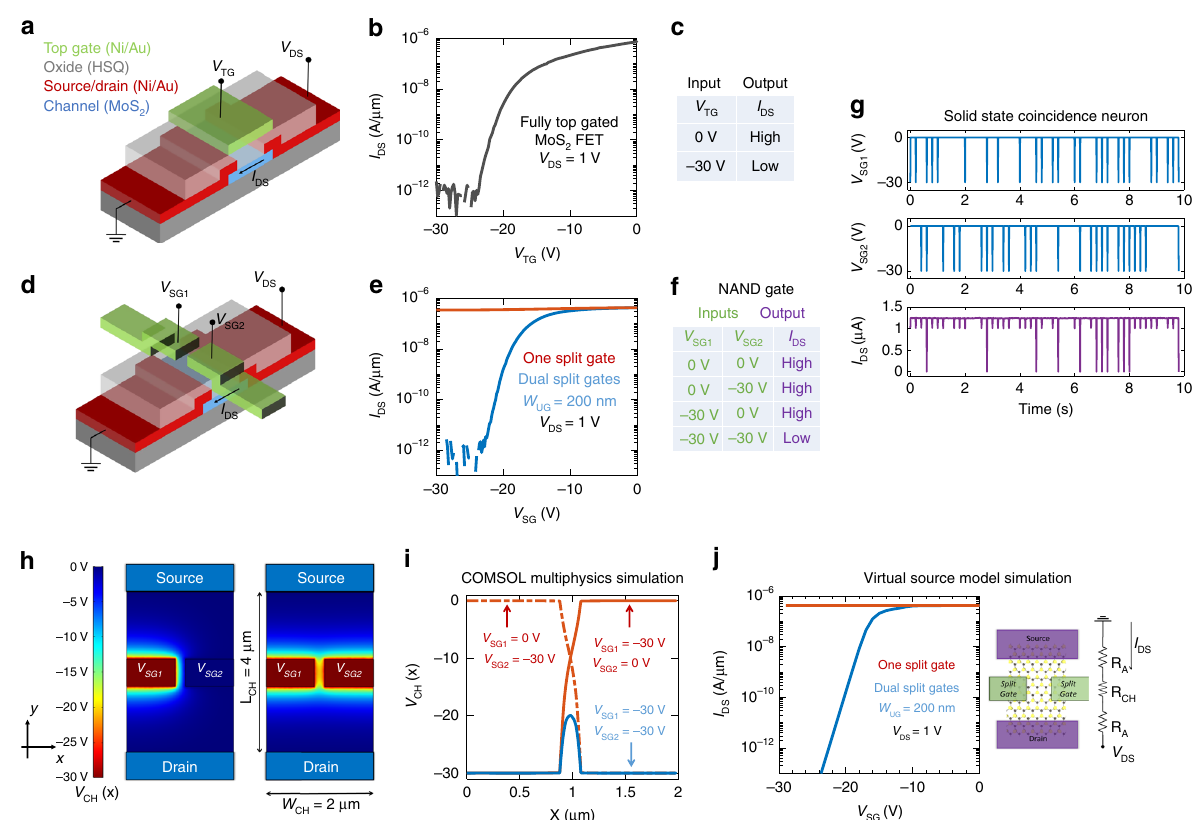
Fig. 2 Arti fi cial coincidence detector neuron. a Schematic and ( b ) Transfer characteristics of a fully top-gated MoS 2 fi eld effect transistor (FET) with 120 nm of hydrogen silsesquioxane (HSQ) as the top-gate dielectric and Ni/Au as the top-gate electrode. MoS 2 channel is few nm thick and is connected to Ni/Au metal contacts that serve as the source/drain terminals. The device is normally ON at V TG = 0 V and can be switched OFF by applying V TG = − 30 V with a high current ON/OFF ratio of ~10 6 . c Truth table showing that the device can be regarded as a one-input-one-output digital element. d Schematic of an MoS 2 FET with two split-gates separated by an ungated region of width W UG = 200 nm. e Transfer characteristics of the split-gated device when one of the split-gates is swept from 0 V to − 30 V while the other split-gate is held at a constant bias of 0 V (red curve) and when both split- gates are simultaneously swept from 0 V to − 30 V (blue curve). f Truth table showing that the split-gated device can be treated as two-input-one-output digital element with NAND logic. g Random sequence of voltage pulses of magnitude − 30 V are applied to the two spilt gates, V SG1 and V SG2 . The output current is completely suppressed or inhibited only when the spikes coincide suggesting that the split-gated MoS 2 FET can be used to mimic neural coincidence. h COMSOL multiphysics simulation of the 2D potential pro fi le when − 30 V bias is applied to either one or both split-gates. i 1D potential pro fi le along the channel width for different combinations of the two split-gate biases shows the effect of fringing electric fi eld and capacitive coupling between the two split-gate electrodes. The channel potential in the ungated region between the split-gates is fi nite under all conditions. The effect is more dramatic when V SG1 = V SG2 = − 30 V. j Simulated transfer characteristics of the split-gated MoS 2 FET using the Virtual Source (VS) model and the electrostatic potential pro fi le, V CH ( x ) along the channel width obtained from the COMSOL simulations. We have used a modi fi ed VS model to calculate channel resistance, R CH that captures the variation in the electrostatic potential along the width of the channel and also to account for the access resistance, R A due to the ungated region along the channel length